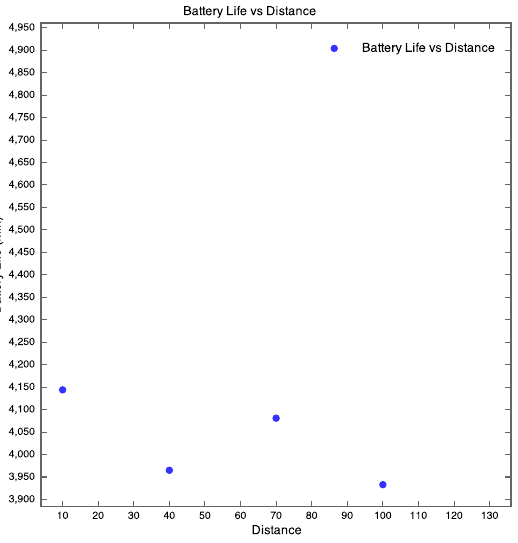
Figure 12. Battery Lifetime vs Distance for Experiment